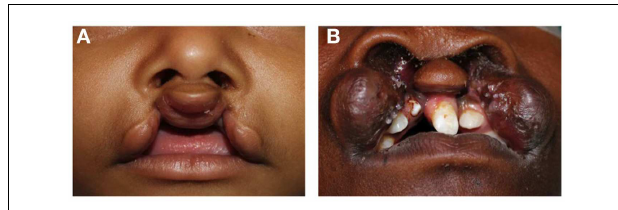
FIGURE 2 | Bilateral cleft lip . (A) Incomplete type, (B) complete type.